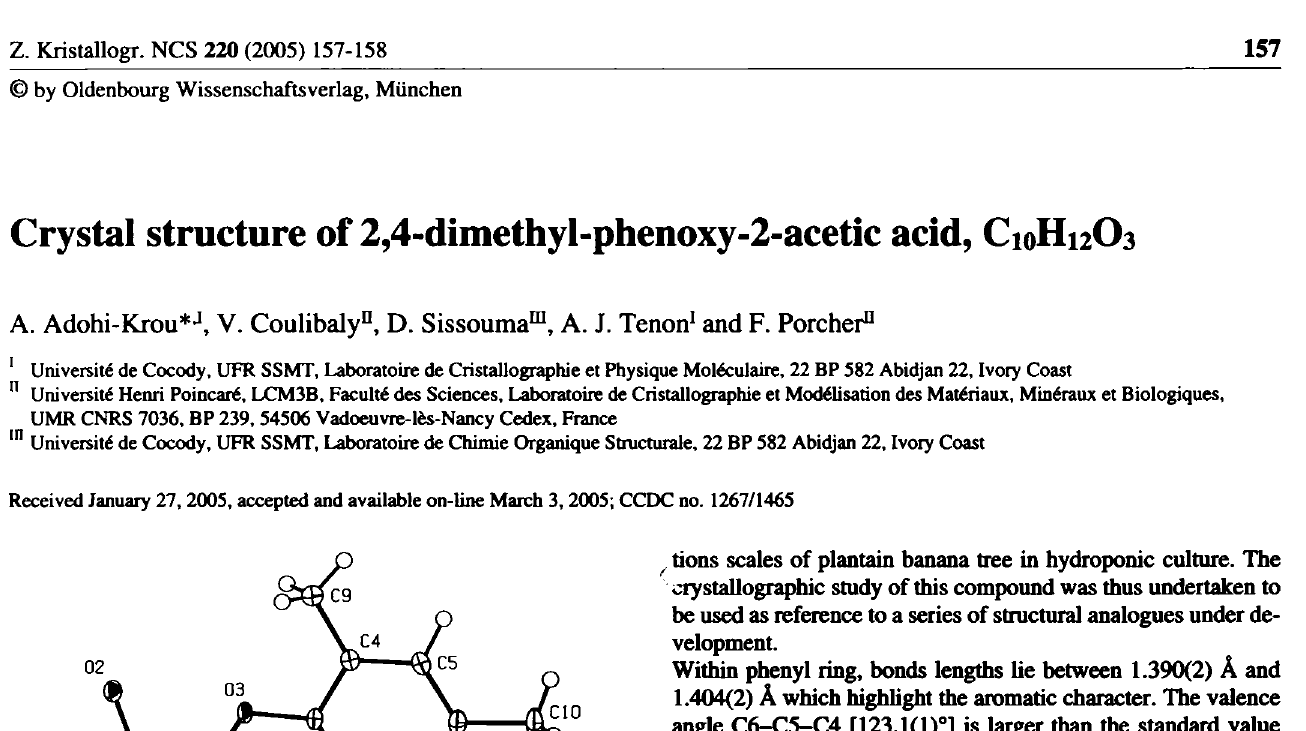
Table 1. Data collection and handling.